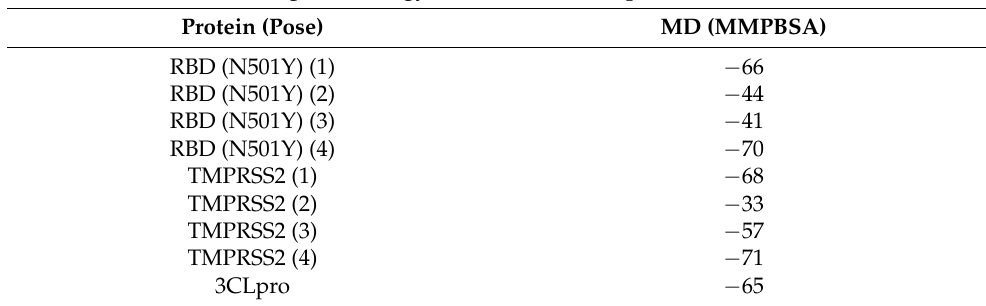
Table 1. Binding free energy between proteins (RBD, TMPRSS2, 3CLpro) and TA for the best poses found during docking. The MD MMPBSA binding free energy is computed over the interval 750 to 1000 ns using the g \ _mmpbsa tools